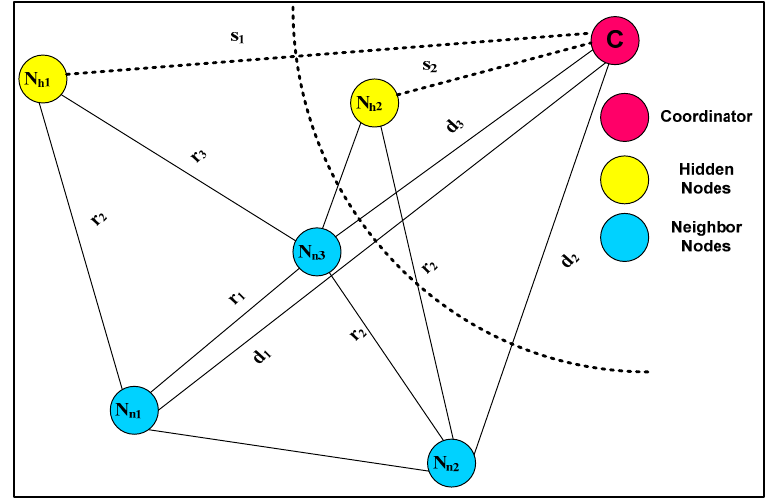
Figure 3. Hidden node discovery process.